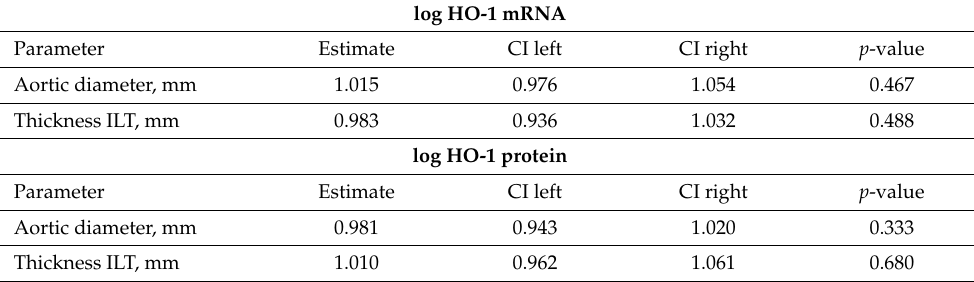
Table 3. Aortic HO-1 mRNA and protein expressions in response to the aortic diameter and the thickness of the intraluminal thrombus (ILT). Data were analyzed by multiple linear regression, and HO-1 mRNA or protein expression was set as the outcome variable. Data for HO-1 were log transformed, and one statistically significant outlier each was omitted from the analysis for mRNA and protein. The estimate represents the proportional increase in HO-1 mRNA and protein expressions with the increase in aortic diameter and ILT thickness per one millimeter. Abbreviations: CI, confidence